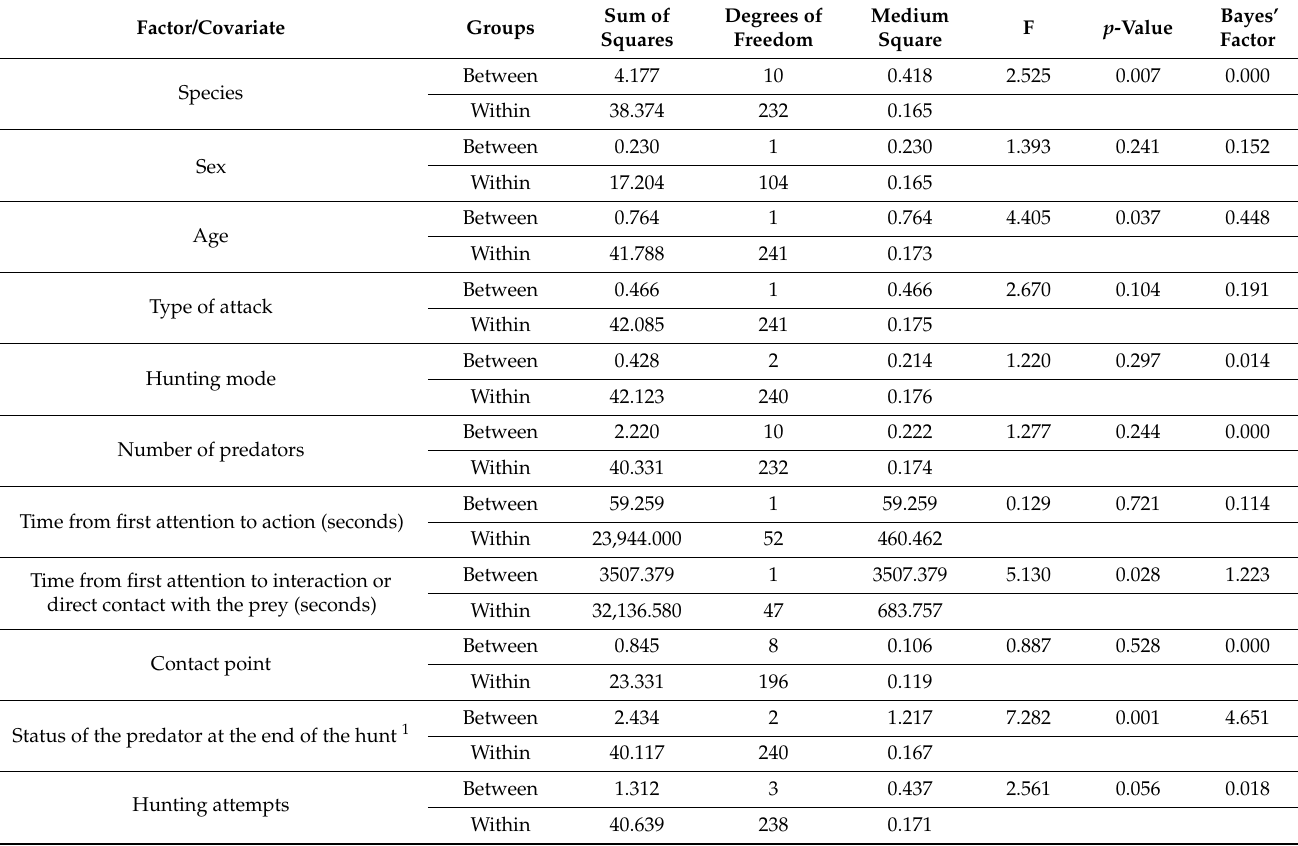
Table 1. Summary of results from Bayesian ANOVA to detect differences in mean probability of success in prey escape across predator-related factors and